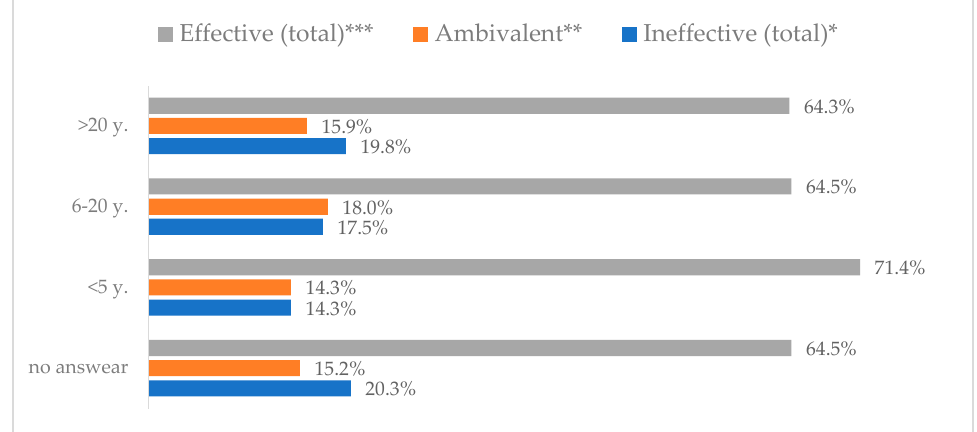
Figure 5. Wearing a protective mask that covers the mouth and nose to prevent influenza virus infection by seniority ( N = 905). *Sum of responses: completely ineffective, ineffective, rather inef- fective; **Response: neither ineffective nor effective; ***Sum of responses: rather effective, effective, completely effective.